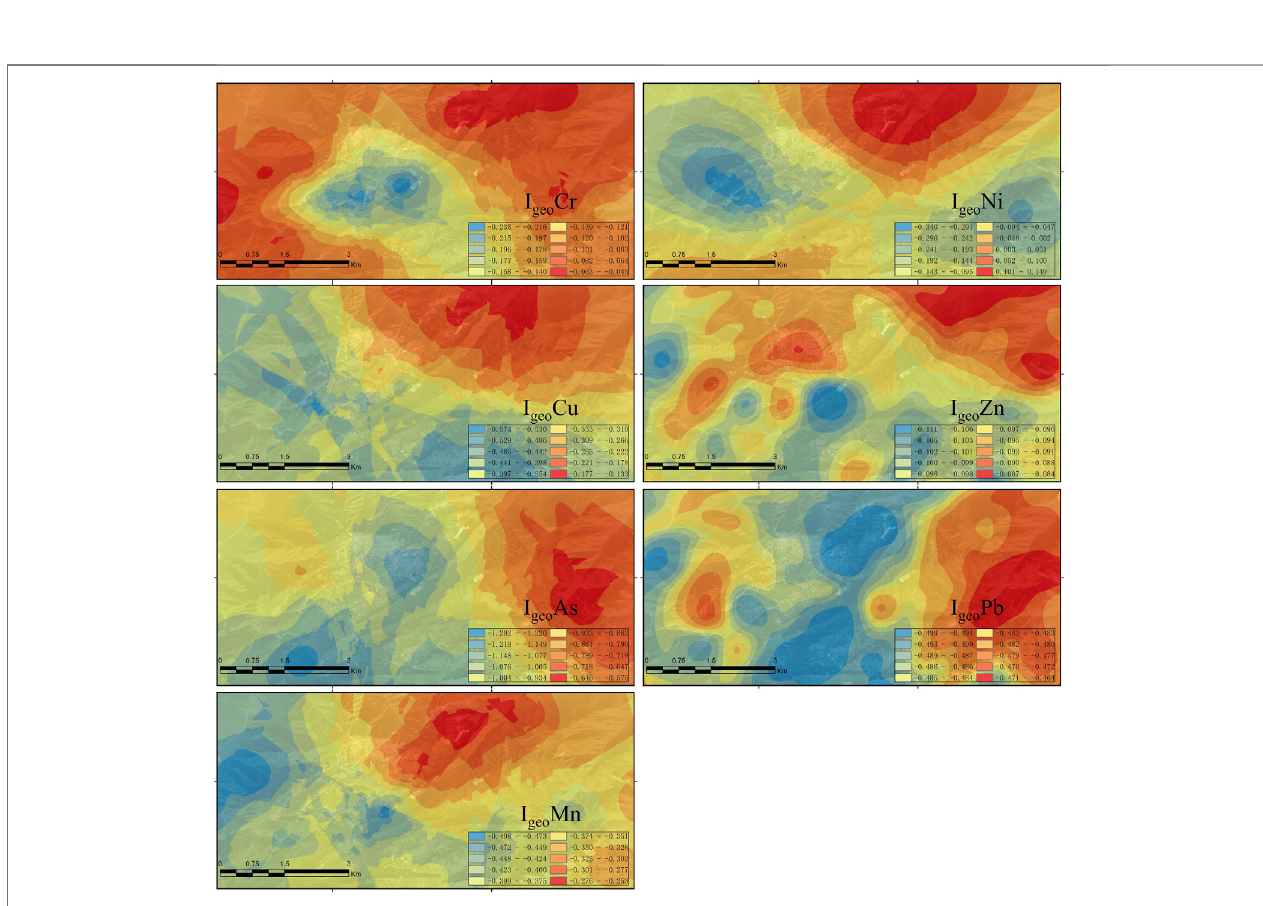
FIGURE 3 | The spatial distribution of I geo values after empirical Bayesian kriging (EBK) interpolation.